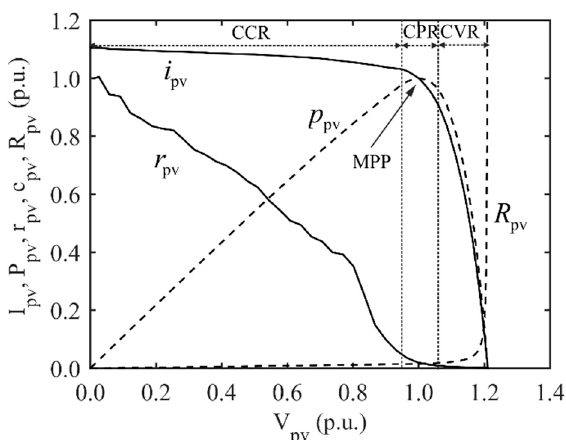
Figure 1. The characteristic per-unit curves of Raloss SR30-36 PV panel (Shanghai Raloss Energy Technology Co. Ltd, Shanghai, PR of China) at the irradiation level of 500 W/m2, where CCR denotes constant-current region, CVR denotes constant-voltage region, and CPR constant-power region, respectively.